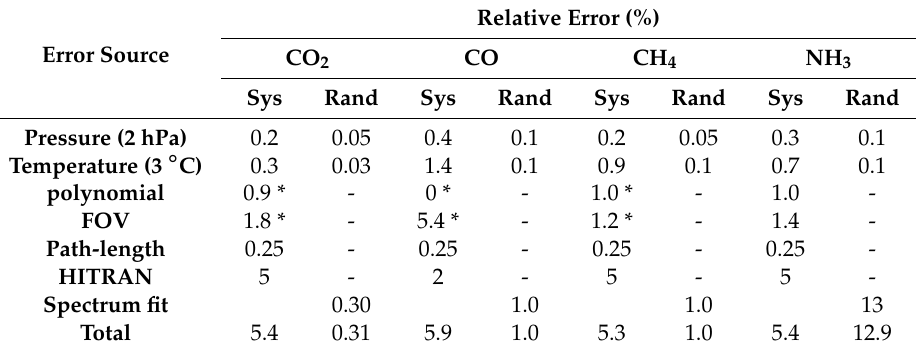
Table 4. The error in the mole-fraction of CO 2 , CO, CH 4 and NH 3 retrieved from OP-FTIR spectra using the MALT forward model, including errors arising from the use of an incorrect polynomial and Field of view (FOV) plus the uncertainty in the measured temperature, pressure and path-length, input into MALT to model the measured spectrum. The error due to an incorrect FOV and polynomial for CO 2 , CO, CH 4 has been taken from Reference [47]. Systematic (sys) and random (rand) errors are reported separately. The uncertainty in the parameters in HITRAN is included in the database. The total is added in